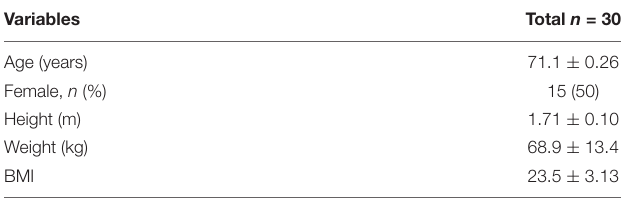
TABLE 1 | Participant characteristics at